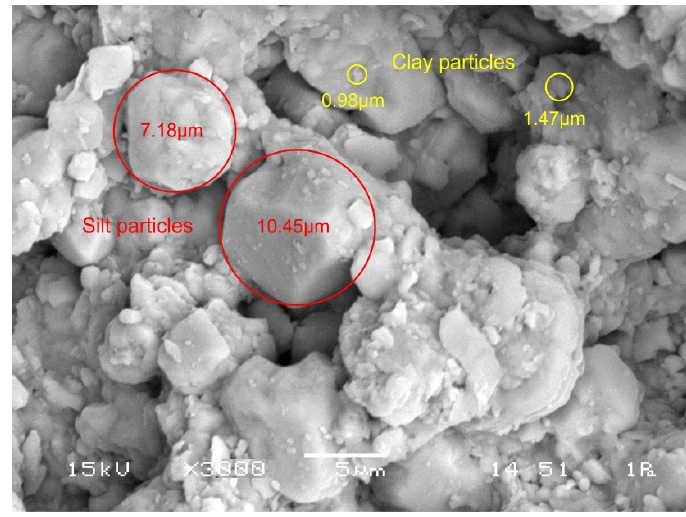
Figure 2. Scanning electron microscope analysis of No.1.